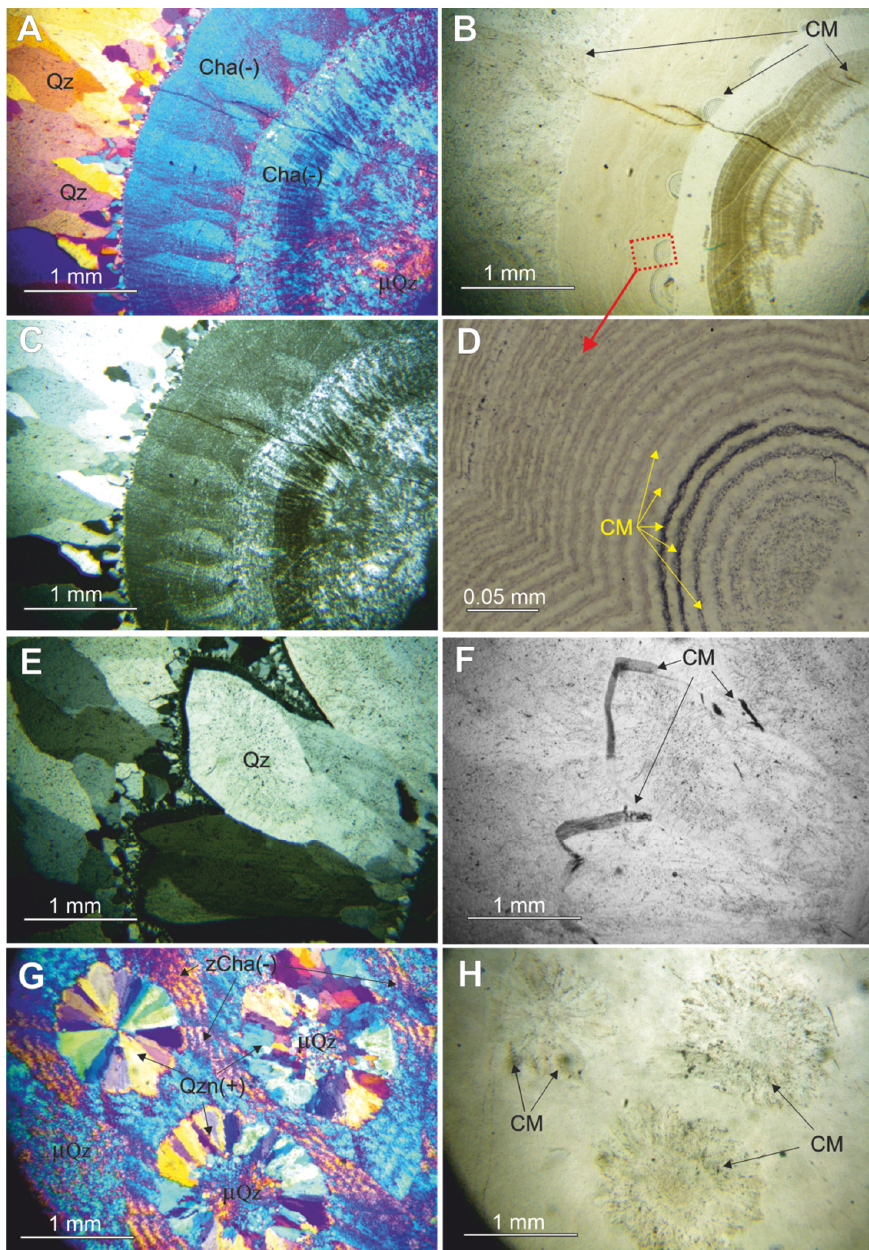
Figure 4. Microphotographs of black Onega agates with disseminated carbonaceous matter (CM): ( A – C ) fragment of the black concentric ellipsoid (from selected area 1, Figure 3C) with alternating zones of length-fast chalcedony, micro- and macro-crystalline quartz in concentrically zoning agate. ( D ) Enlarged fragment (from selected area of ( B )) with fine concentric bands of chalcedony, between which CM is disseminated. ( E , F ) Fragment of the black concentric ellipsoid (from selected area 2, Figure 3C) with black jagged band containing carbonaceous pigment developed at the edges of euhedral prismatic quartz crystals (Figure 3C, area 2). ( G , H ) Spherolites of radial fibrous quartzine in microcrystalline quartz matrix with zebraic chalcedony zones (Figure 3E). ( A , G ) Polarised light, crossed nicols, compensator plate. ( C , E ) Polarised light, crossed nicols. ( B , D , F , H ) Plane polarised light. ( B , D , F , H ) Photos show that the macroscopic black colour is caused by an accumulation of CM in the local agate zones. Abbreviations: Cha(-): length-fast chalcedony; zCha( − ): zebraic chalcedony; Qzn(+): length-slow chalcedony (quartzine); Qz: macrocrystalline quartz; μ Qtz: microcrystalline quartz.